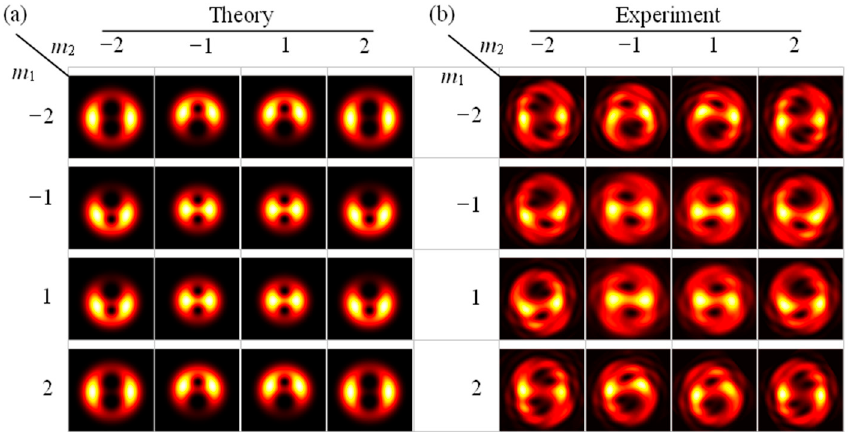
Figure 5. ( a ) Theoretically simulated and ( b ) experimentally measured intensity patterns of off-axis double vortex beams with different values of m 1 and m 2 when w = 2.5 mm, x 1 = x 2 = 0, and Δ = 0.5 w